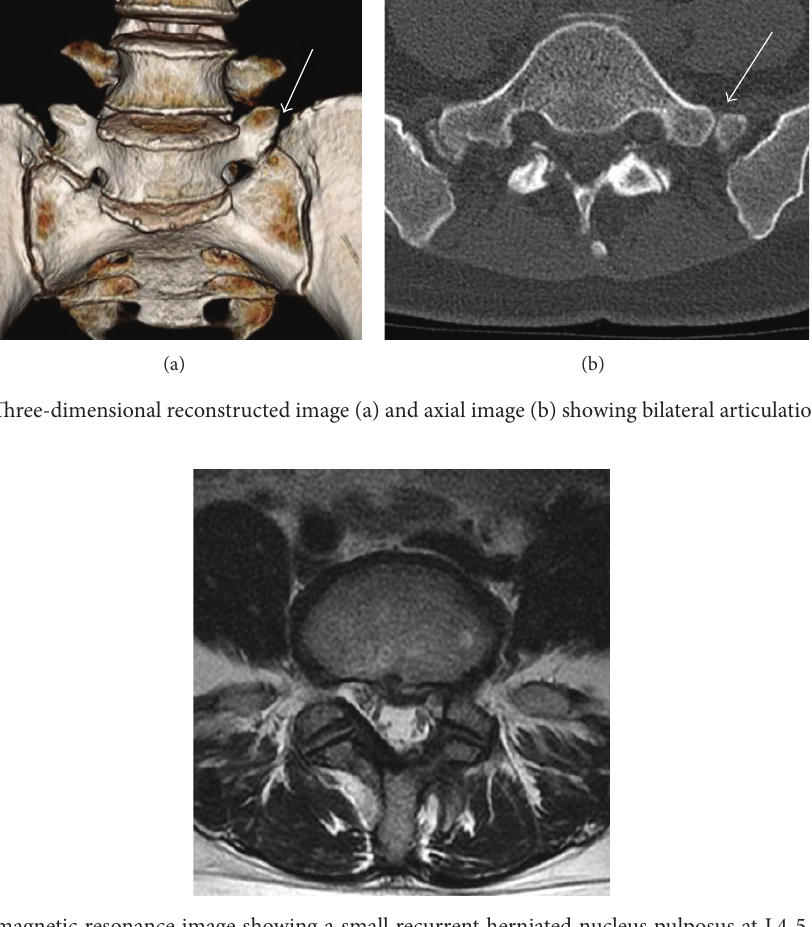
Figure 2: Preoperative magnetic resonance image showing a small recurrent herniated nucleus pulposus at L4-5 compressing the left L5 nerve.